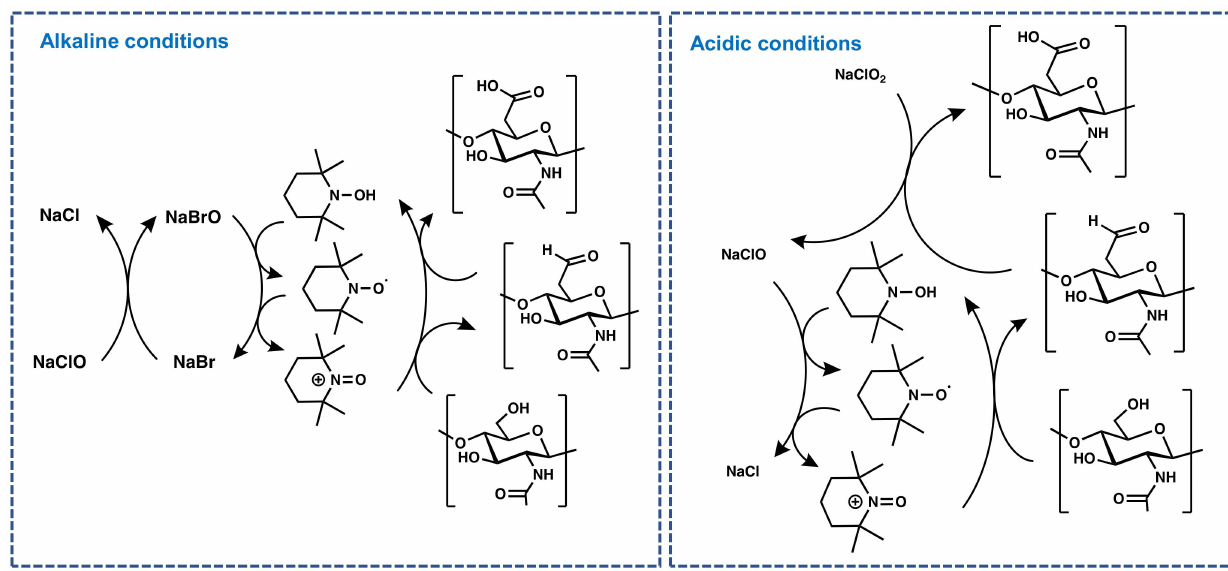
Figure 3. Schematic representation of TEMPO-mediated oxidation under alkaline and acidic